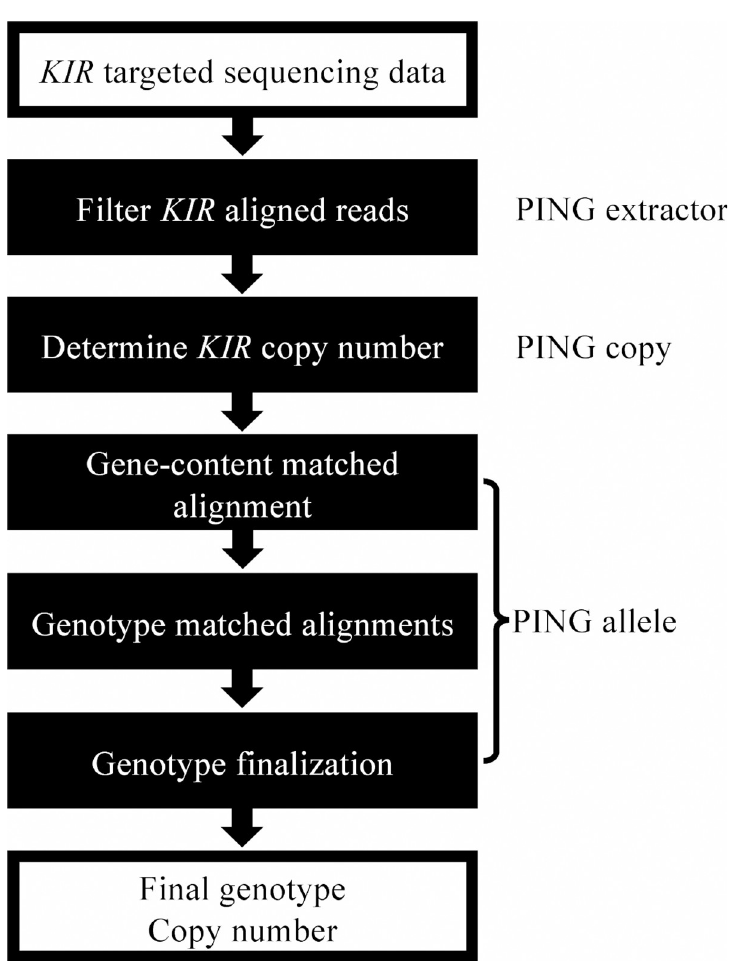
Fig 1. Overview of the PING pipeline. The PING pipeline processes KIR targeted sequencing data to determine KIR gene copy number and allele genotypes through a series of modules. First, KIR aligned reads are filtered through an alignment to a set of KIR haplotypes in PING extractor. Second, copy number of KIR genes are determined through an exhaustive alignment to a diverse set of KIR sequences in PING copy. Finally, PING allele performs a series of alignments to determine the most congruent KIR genotype, which informs a final round of alignment and genotype determination. Additionally, PING reports any identified novel SNPs and new alleles (SNP combinations not found in any described KIR allele